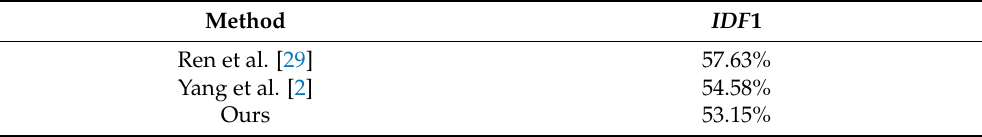
Table 6. Comparison to the state-of-the-art